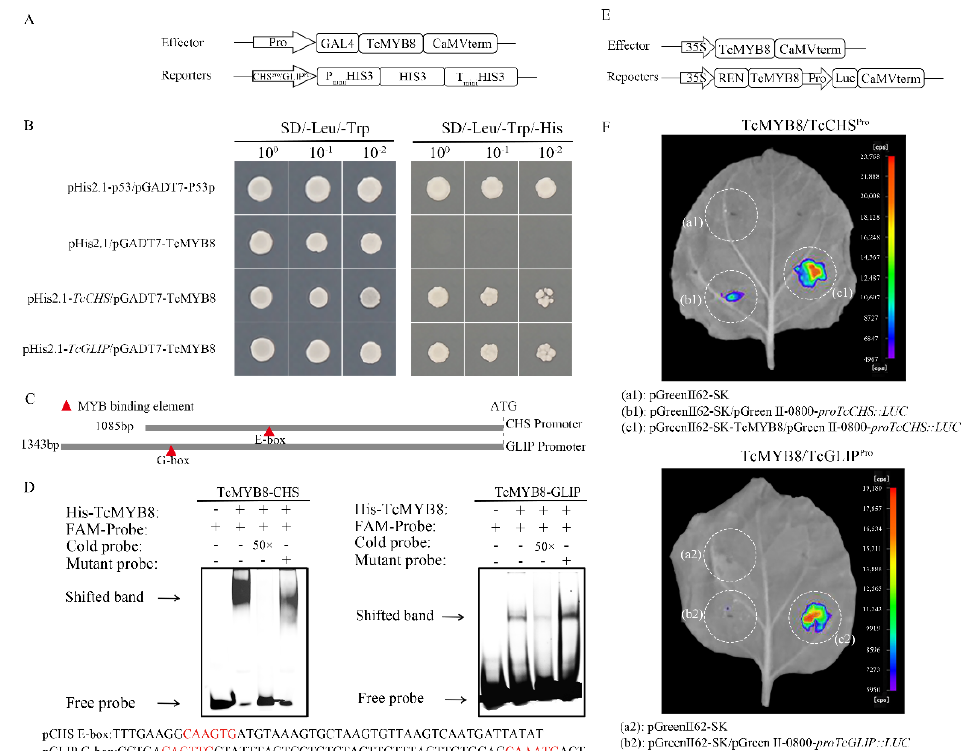
Figure 4. TcMYB8 directly binds to and activates the promoters of TcCHS and TcGLIP . ( A ) Schematic representation of the vectors used to perform Y1H assays. The proTcCHS/proTcGLIP was constructed into the pHis2.1 vector, while the TcMYB8 was constructed into the pGADT7 vector. ( B ) Y1H assay showing that TcMYB8 binds to proTcCHS/proTcGLIP . Ten-fold serial dilutions of yeast cells carrying the constructs were plated on SD/-Leu/-Trp and SD/-Leu/-Trp/-His media. The pHIS2.1-p53 and pGADT7-p53 plasmids were used as positive controls. ( C ) Schematic diagram of E-box and G-box elements in the proTcCHS/proTcGLIP . ( D ) Electrophoretic mobility shift assay (EMSA) showing the direct binding of TcMYB8 to proTcCHS/proTcGLIP . The labeled probe (10 μ M) was competed with a 50-fold excess of unlabeled wild-type cold probes and unlabeled mutant probes. The black arrows indicate shifted bands and free bands, respectively. ( E ) Schematic repre- sentation of the constructs used for transient expression assays. The TcMYB8 gene was cloned downstream of the 35S promoter in the pGreen-62-SK vector to generate the effector construct, and the proTcCHS/proTcGLIP were separately cloned upstream of the LUC gene in the pGreen II-0800- LUC vector to generate the reporter constructs. ( F ) Transient expression assays showing that TcMYB8 binds to proTcCHS/proTcGLIP. (a1): pGreen-62-SK empty vector as the negative control, (b1): pGreen-62-SK/pGreen II-0800- proTcCHS::LUC , (c1): pGreen-62-SK-TcMYB8/pGreen II-0800- proTcCHS::LUC , (a2): pGreen-62-SK empty vector as the negative control, (b2): pGreen-62- SK/pGreen II-0800- proTcGLIP::LUC , (c2): pGreen-62-SK-TcMYB8/pGreen II-0800- proTcGLIP::LUC . 3. Discussion 3.1. TcMYB8, a 1R-MYB TF, Is a Novel MYB TF Found in T. cinerariifolium MYB proteins are grouped into four classes (1R-, 2R-, 3R-, and 4R-MYB) based on the number of adjacent repeats (R) [32,33]. In the present study, we identified a novel 1R-MYB TF in T. cinerariifolium , TcMYB8, with a typical R3-type domain (primary structure: -F- X18-W-X18-W-) at the N terminus (Figure 1A). The 1R-type MYB TF genes, such as ( Ara- bidopsis ) TRIPTYCHON ( TRY ) and ( Actinidia eriantha ) AceMYBS1 , are likely to have evolved from R2R3-MYB genes and are involved in epidermal cell patterning [34] and secondary metabolism control [35,36]. Among the flower and leaf expression patterns, the expression trends of TcMYB8 were especially consistent with that of TcCHS and TcGLIP (Figure S2), suggesting that